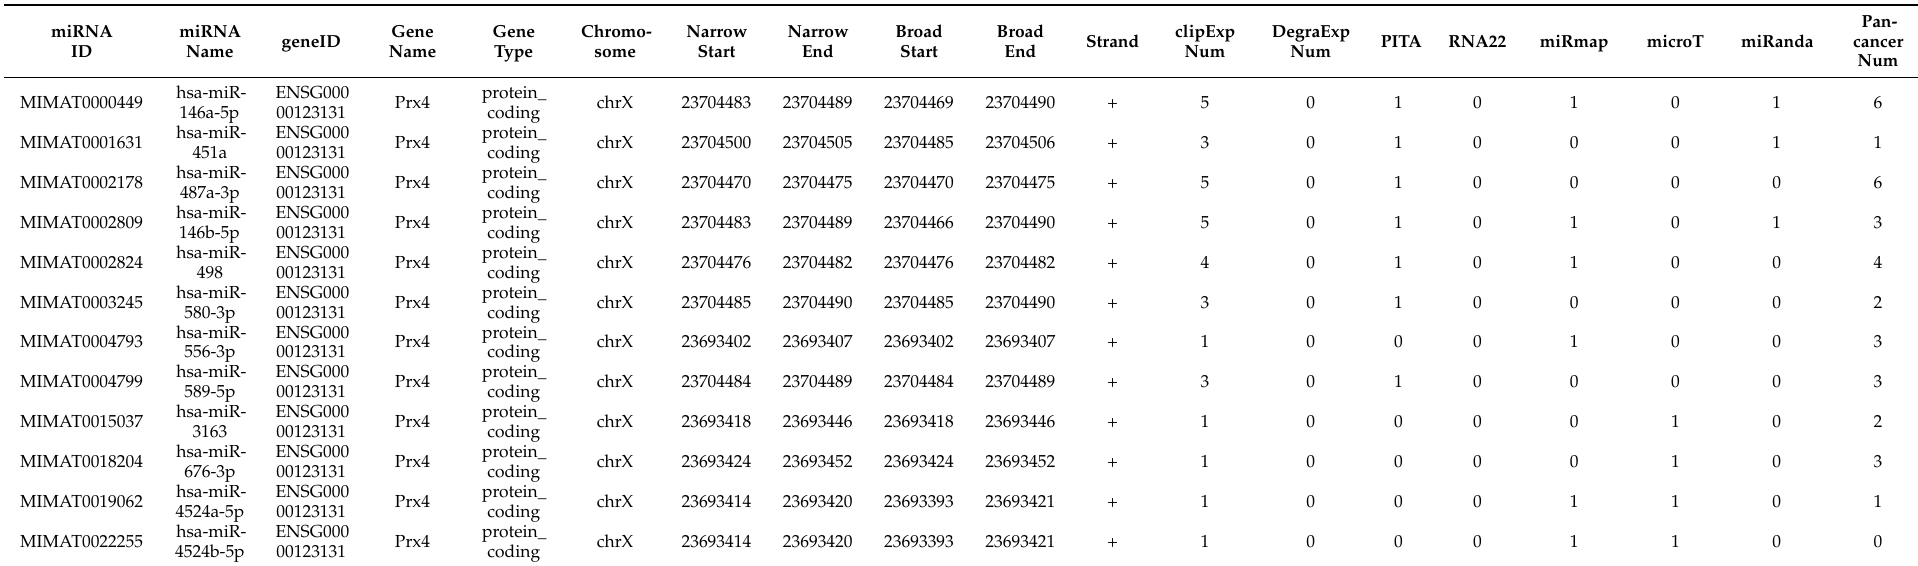
Table 3. The 12 predicted miRNA from ENCORI